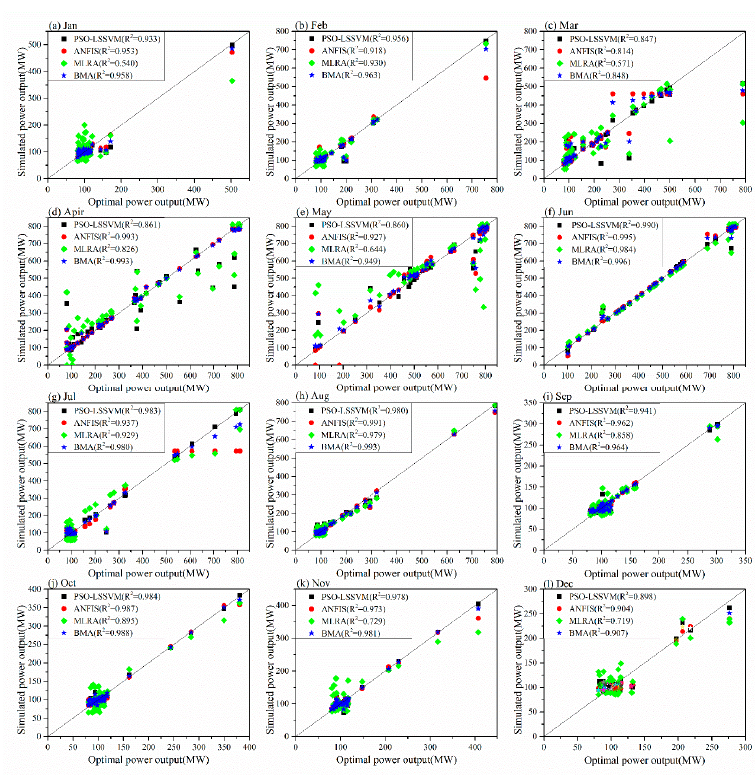
Figure 6. Scatter plots of the monthly power output given by PSO-LSSVM, ANFIS, MLRA, and BMA under the optimal trajectory.